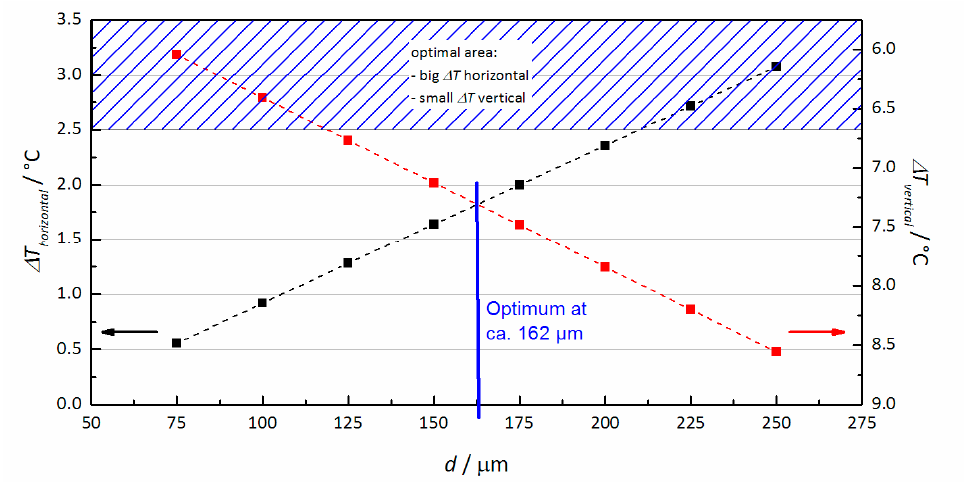
Figure 2. New thermoelectric sensor with a low temperature transfer tape (LTTT) layer laminated on alumina